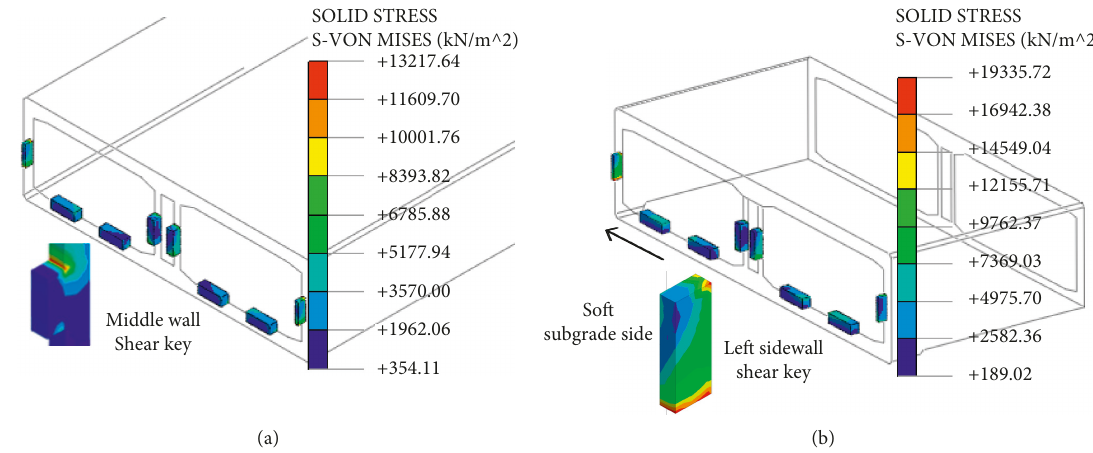
Figure 25: The von Mises stress nephogram of the shear key of (a) joint 1 on segment E1 under working condition 7 and (b) joint 2 on the Haizhu segment under working condition